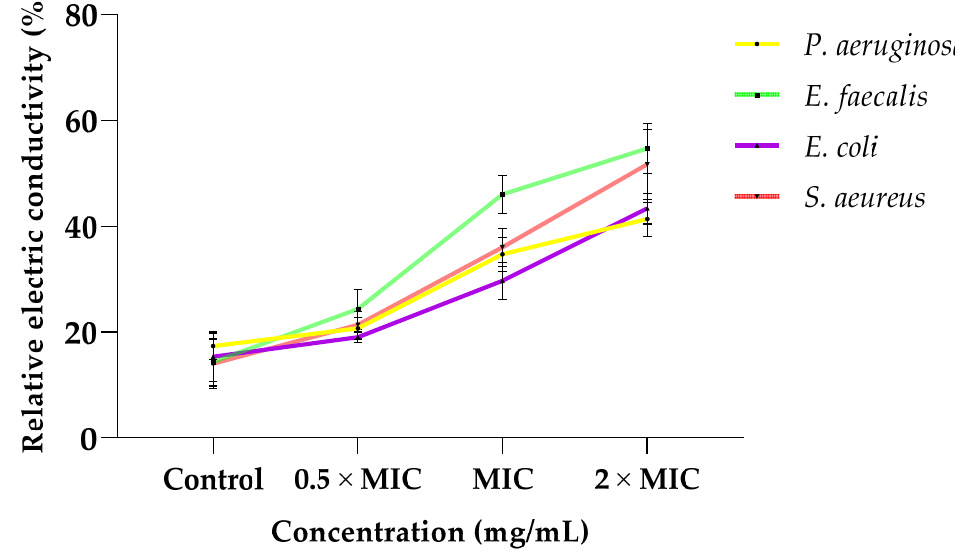
Figure 3. The effect of the whole leaf extract on the cell membranes of P. aeruginosa , E. faecalis , E. coli and S. aureus .